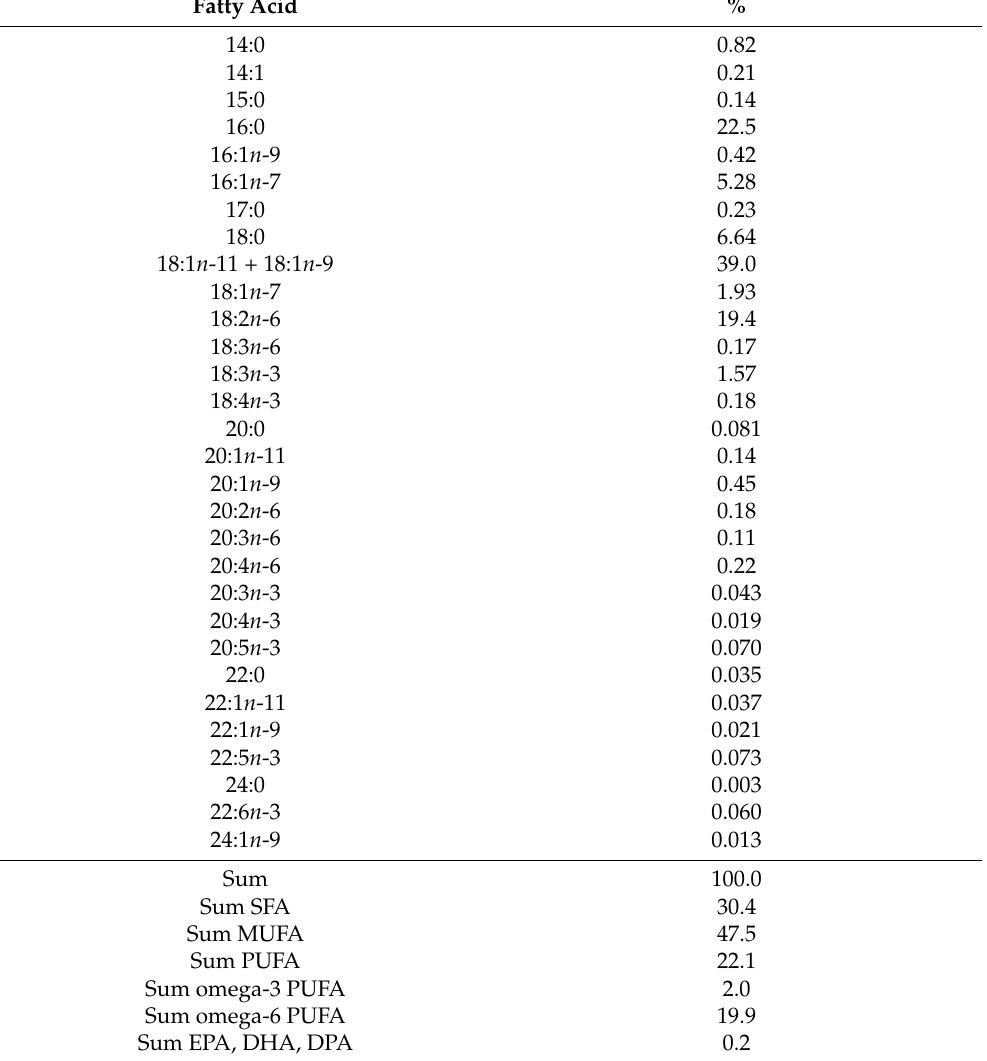
Table 2. Fatty acid composition of chicken